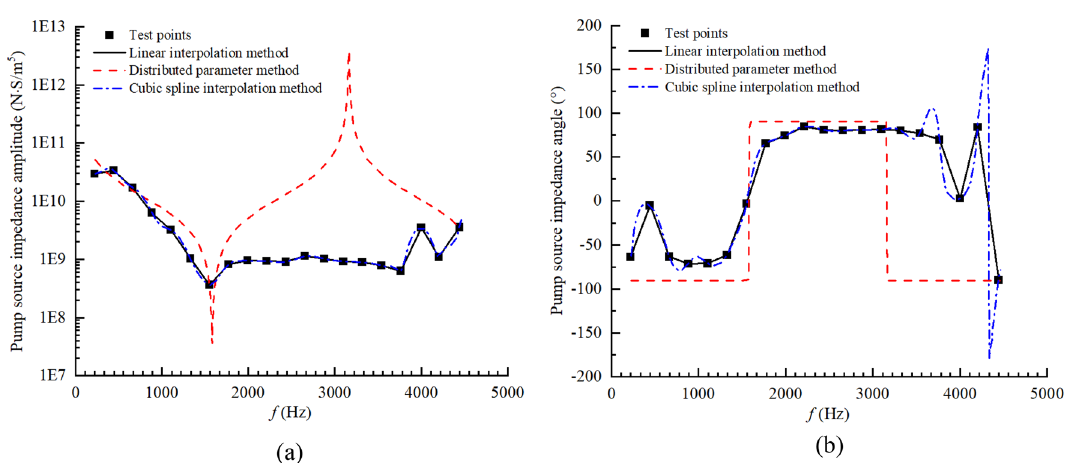
Figure 29. ( a ) Amplitude–frequency curve of Z SM and ( b ) phase-frequency curve of Z SM .